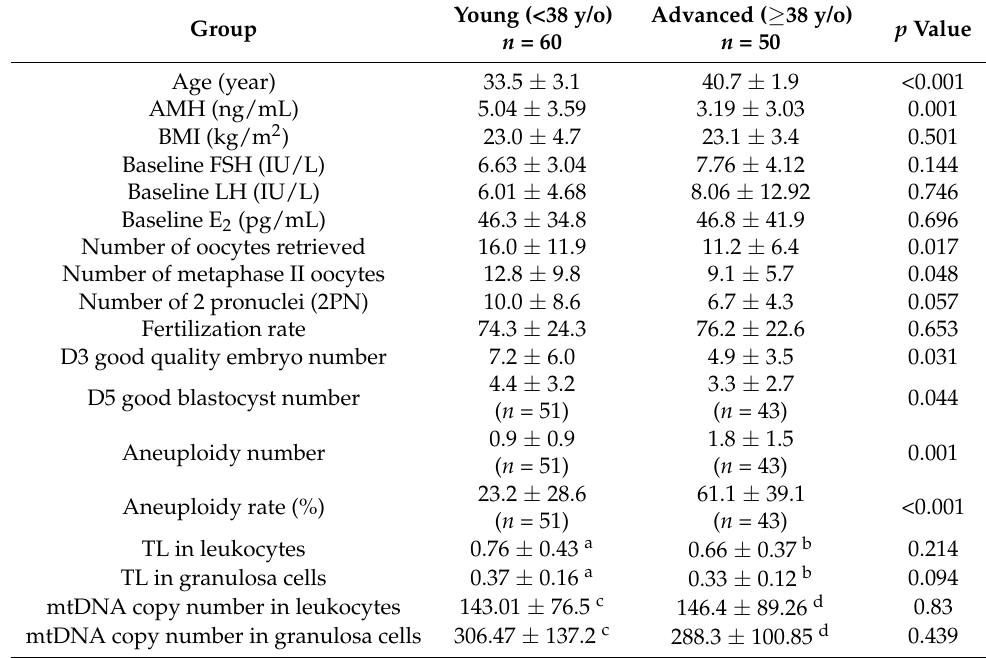
Table 1. Demographic characteristics of the study patients. P values are determined by Mann-Whitney U test.